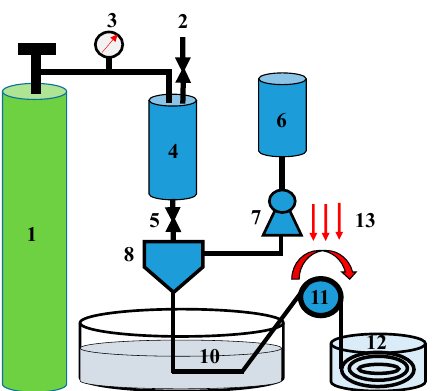
Figure 3. Typical hollow fiber spinning system: 1. spinning dope tank, 2. regulating pressure valve, 3. pressure gauge, 4. dope vessel, 5. dope valve, 6. bore liquid vessel, 7. bore liquid pump, 8. spinneret, 9. air gap, 10. Coagulation bath, 11. windup drum, 12. fiber collecting reservoir and 13. wash water.